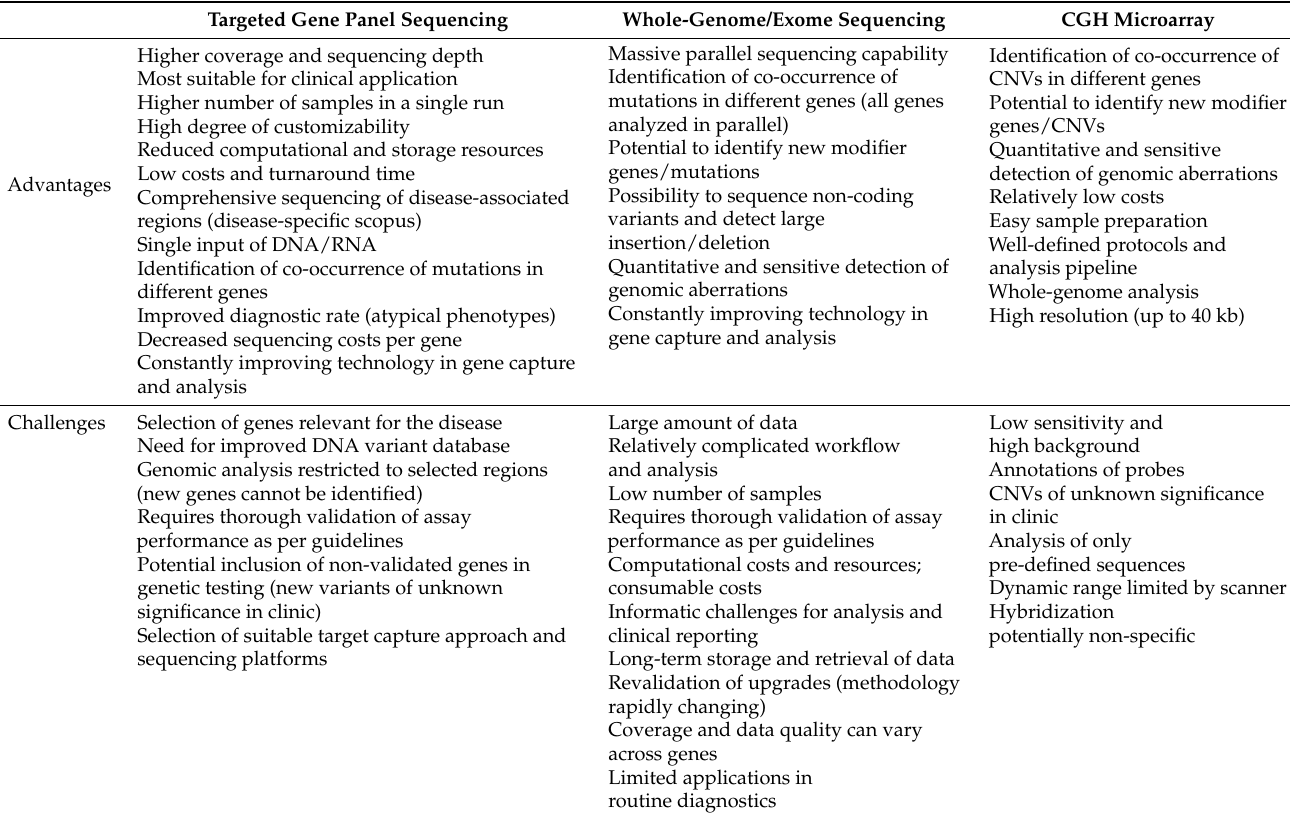
Table 2. Advantages and challenges of various high-throughput